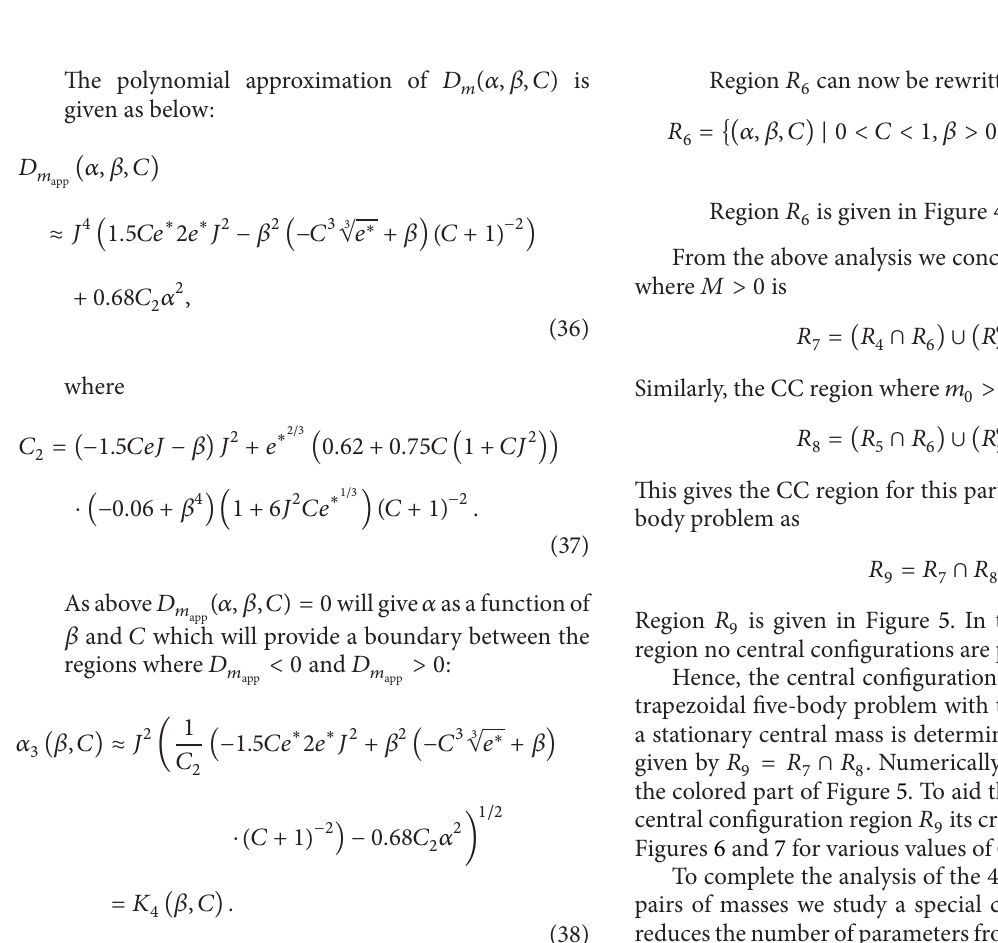
Figure 5: Central configurations region in the isosceles trapezoid 4 + 1-body